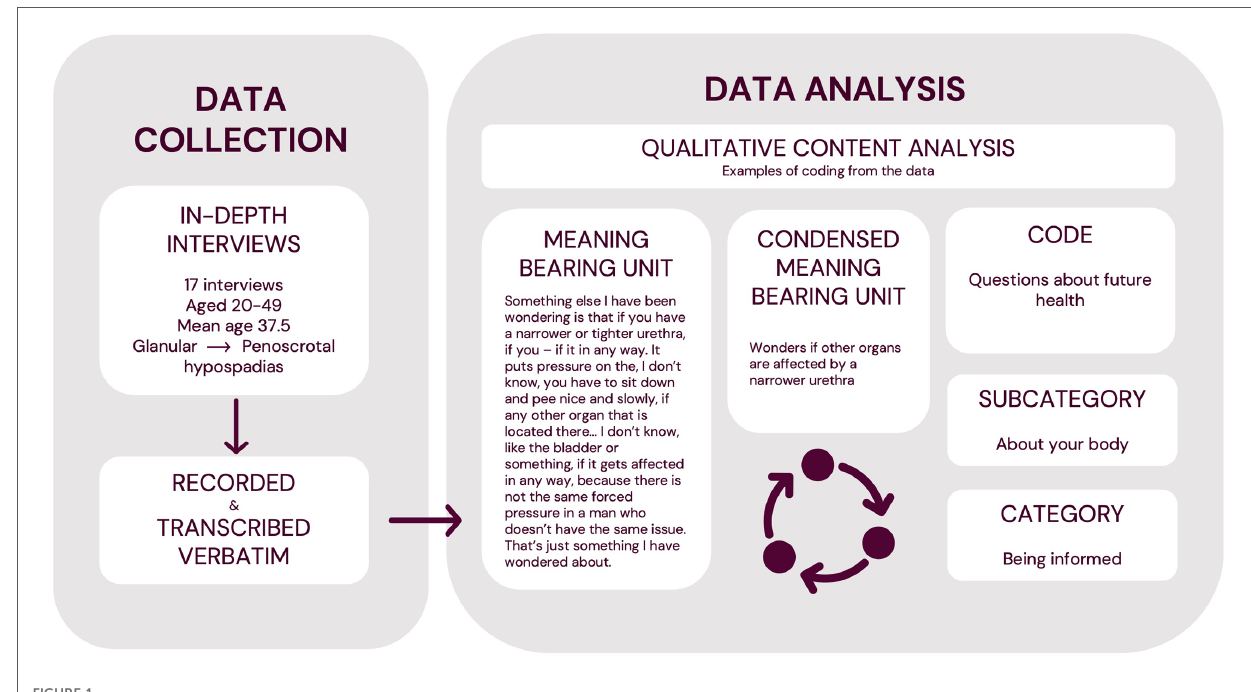
FIGURE 1 Overview of the data collection and analytical